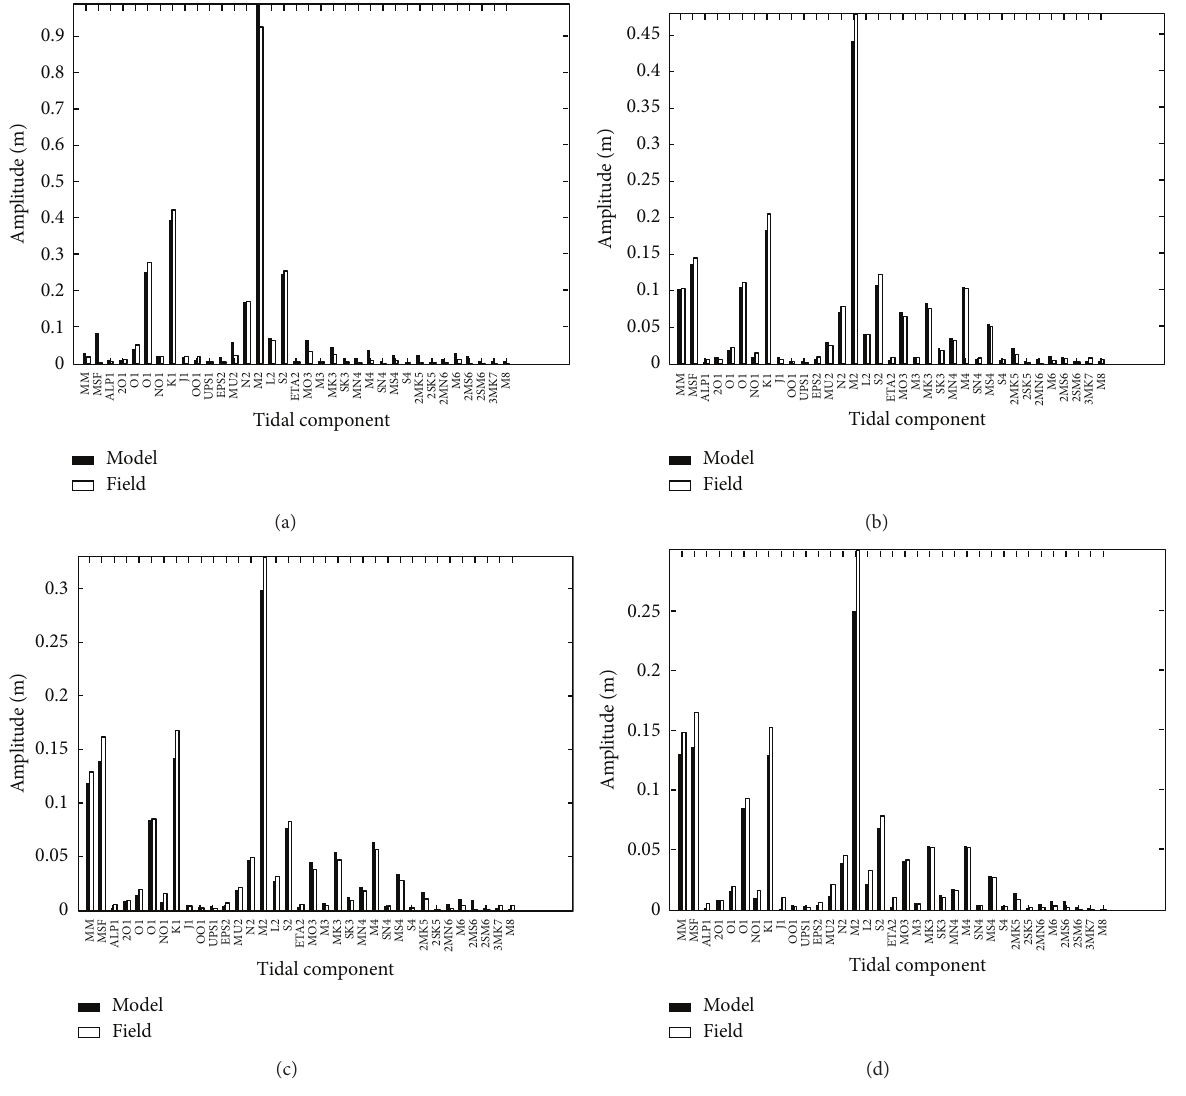
Figure 7: Tidal amplitudes at (a) Astoria, (b) Longview, (c) Saint Helens, and (d)